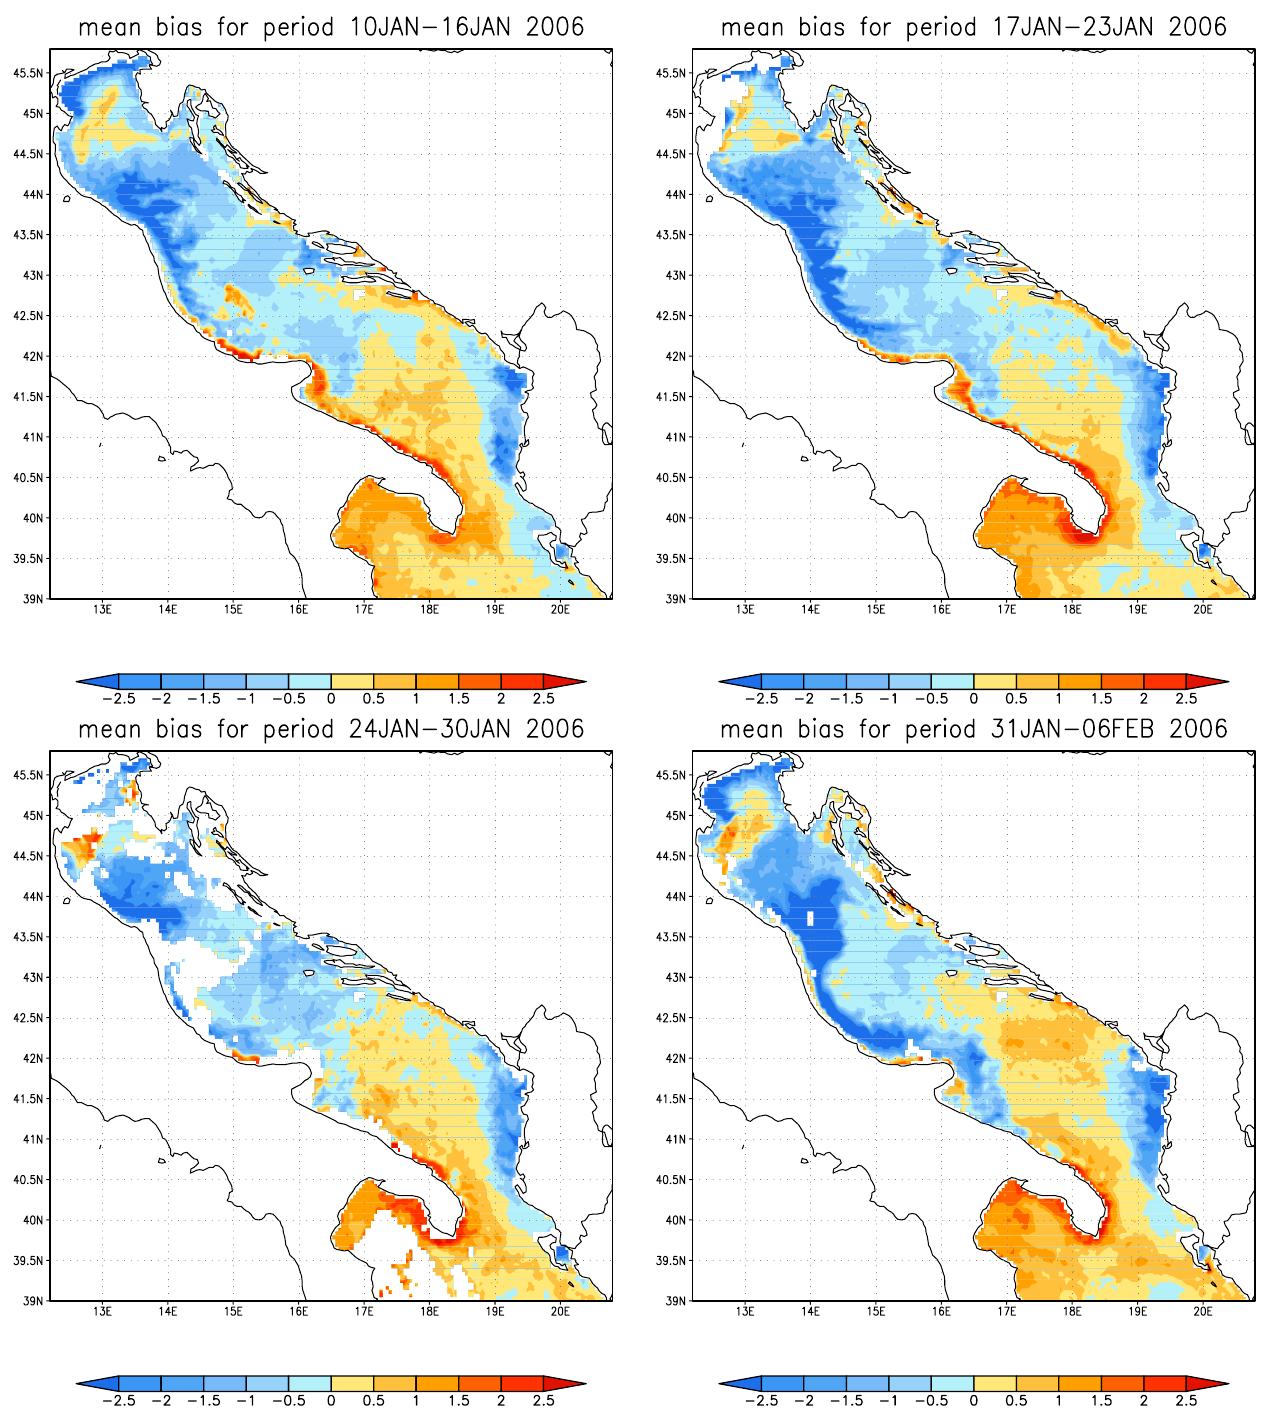
Fig. 5. Mean SST BIAS over the Adriatic area for four periods of seven days each: 10–16, 17–23, 24–30 January, and 31 January–6